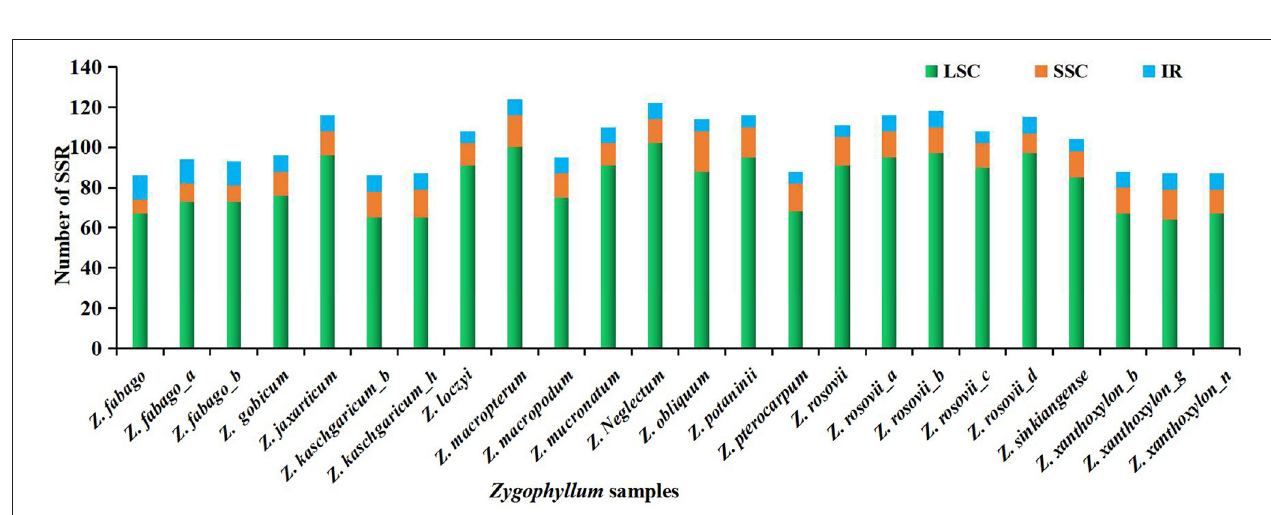
FIGURE 5 | Number of simple sequence repeats (SSRs) from 24 Zygophyllum samples.